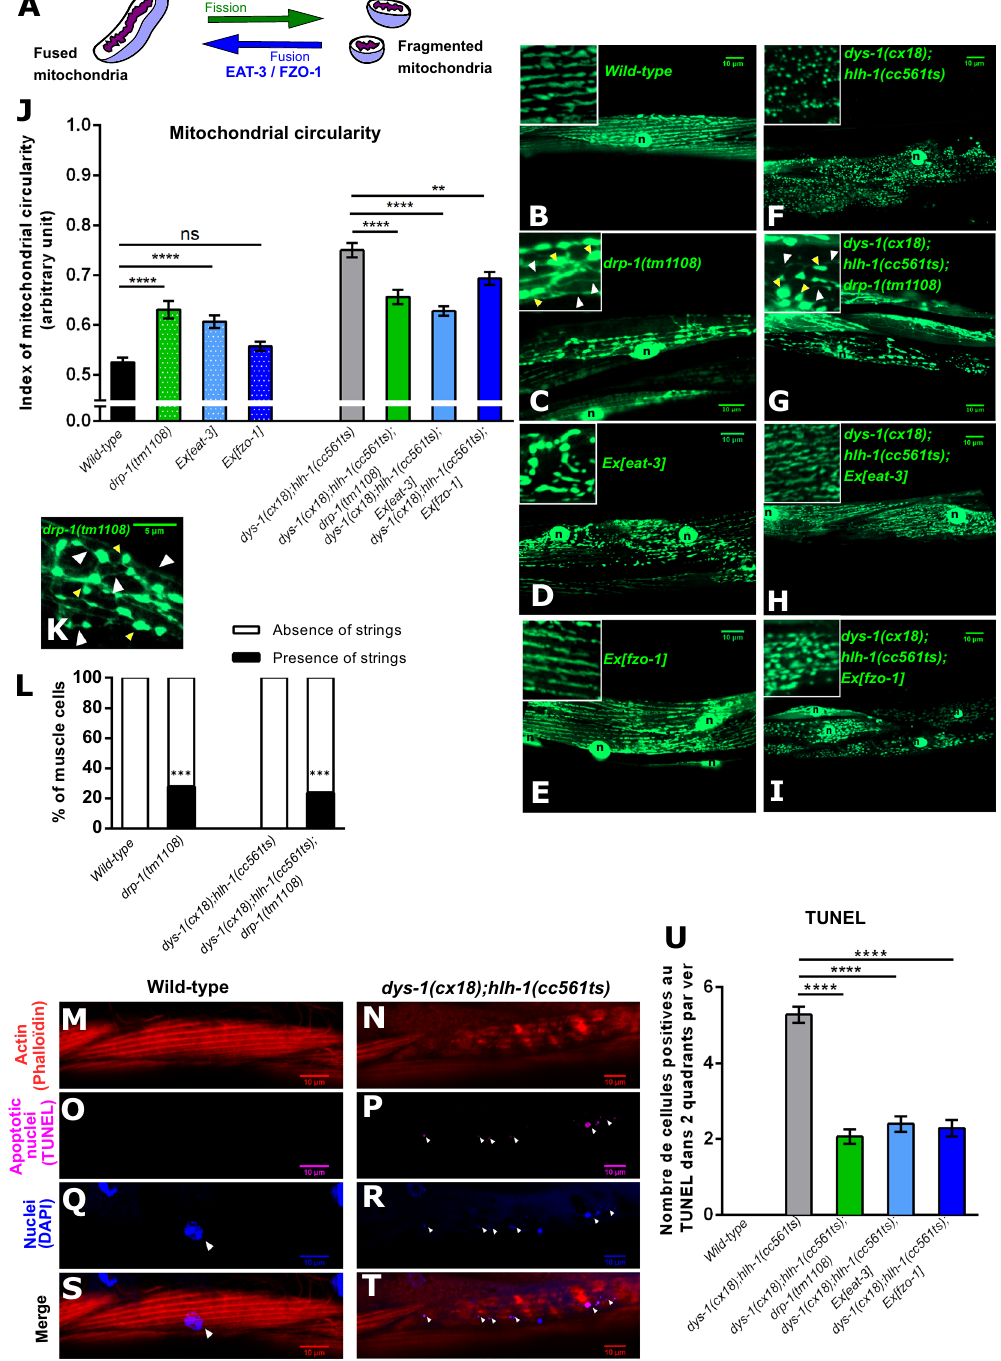
Figure 1. DRP-1 induces mitochondrial fragmentation and apoptosis upon dystrophin-dependent muscle degeneration. ( A ) Schematic representation of the main mitochondrial dynamics actors in C. elegans . Representative confocal images of the mitochondrial network organization visualized with the ccIs4251 transgene in C. elegans body wall muscle cells of: ( B ) wild-type worms; ( C ) drp-1(tm1108 ) mutant worms; ( D ) worms overexpressing eat-3; ( E ) worms overexpressing fzo-1; ( F ) dys-1(cx18);hlh-1(cc561ts) mutant worms; ( G ) dys-1(cx18);hlh-1(cc561ts) ; drp-1(tm1108) mutant worms; ( H ) dys-1(cx18);hlh-1(cc561ts) overexpressing eat-3 mutant worms and ( I ) dys-1(cx18);hlh-1(cc561ts) overexpressing fzo-1 mutant worms. Scale bar 10 μ m (x630). n indicates nuclei. Yellow arrowheads indicate bubble-like shape mitochondria. White arrowheads indicate mitochondria connecting strings. ( J ) Quantification of mitochondrial circularity in each of the indicated strains (n = 29 worms at least). ( K ) Representative confocal image of thin mitochondrial filaments in between blebs of mitochondria in the drp-1(tm1108) mutant worms. Scale bar 5 μ m (x630). Yellow arrowheads indicate bubble- like shape mitochondria. White arrowheads indicate mitochondria connecting strings. ( L ) Percentage of muscle cells exhibiting strings in between blebs of mitochondria in each of the indicated strains (n = 54 worms at